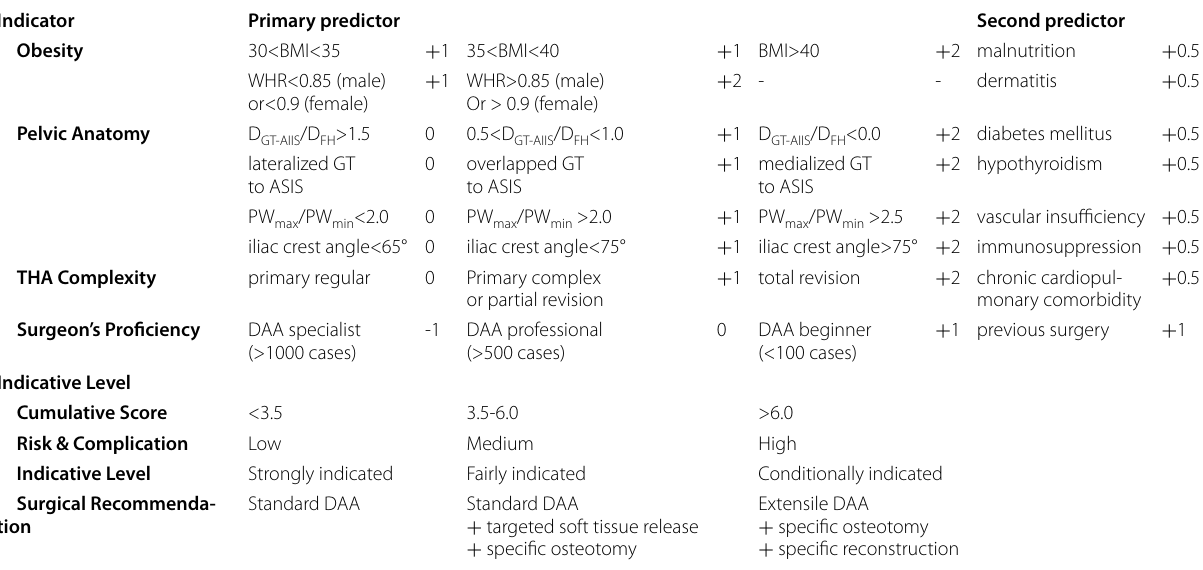
Table 1 A Xinqiao-proposed predictive algorithm to determine indicative level and feasibility for DAA by a cumulative score method